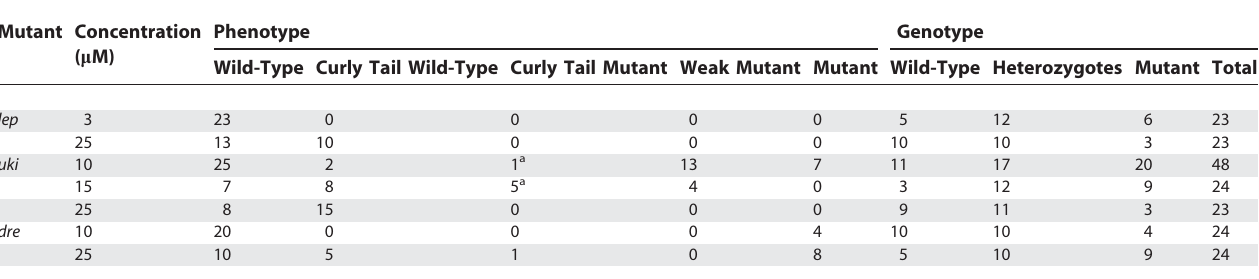
Table 1. Rescuing Experiment Using Cyclopamine on uki, dre, and lep Mutants Mutant Concentration Phenotype ( l M)